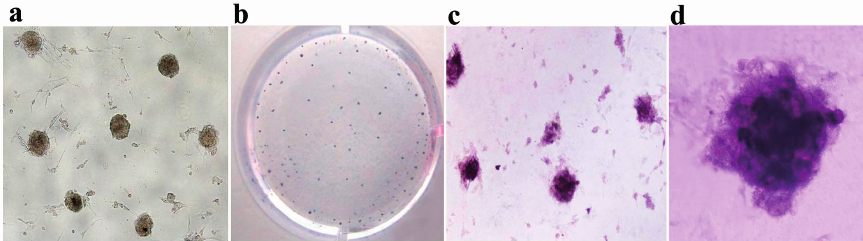
Figure 7. Characterization of the mRNA induced pluripotent stem cells (iPSCs). ( a ) The morphological characteristics of iPSCs with round ES-like colonies were distinguished by tightly defined borders and a high nuclear/cytoplasm ratio (magnification 40×); ( b – d ) showed positive alkaline phosphatase activity of the mRNA iPS either grossly ( b , magnification 10×) or through microscopic observation ( c , magnification 100×) and ( d , magnification 200×); ( e ) Total RNA was isolated from three mRNA iPS clones and non-transfected MEF cells were used for RT-PCR to detect expression of pluripotency markers: Oct4 , Sox2 , Nanog , Rex1 , Klf4 and cMyc . Results showed that iPS colonies expressed all markers in contrast to MEF cells; ( f ) Detection of the methylation status of Nanog and Oct4 promoters in both MEF cells, iPS and ESCs by bisulfite sequencing revealed a high percentage of de-methylation in both promoters compared to the parent MEF cells. Open circles indicate the un-methylated state and dark, filled circles indicate the methylated